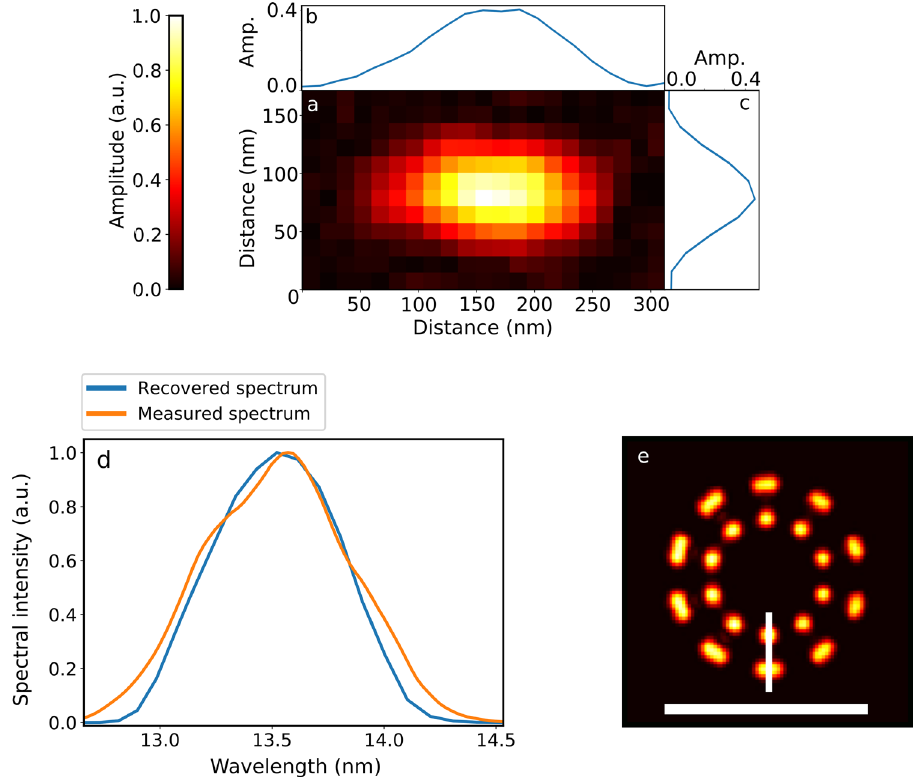
Fig. 5 Extraction of the spectrum and broadband phase retrieval. a The average of fi ve cross-correlations of two reference apertures each. b , c The lineouts of the averaged cross-correlation terms, which are averaged over the vertical and horizontal axis. d Spectrum obtained by deconvolving b with c , which is compared to the measured spectrum (orange). e Reconstructed object after applying a broadband, iterative phase retrieval algorithm on the measured diffraction pattern with Fig. 3e as the initial fi eld and Fig. 5d as input spectrum. The scale bar in e corresponds to 1 µ m. The amplitude and spectral intensity is given in arbitrary units